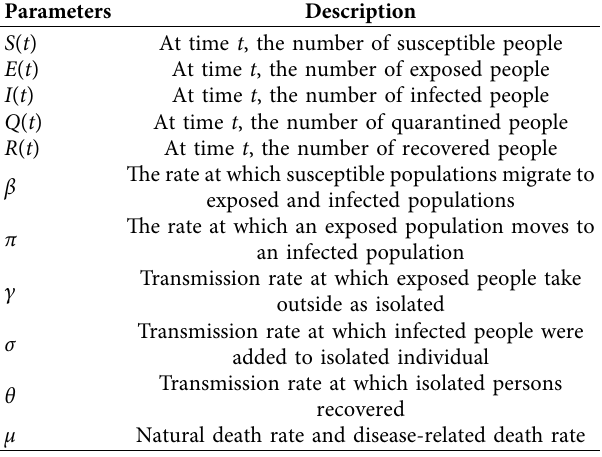
Table 2: Parameters and